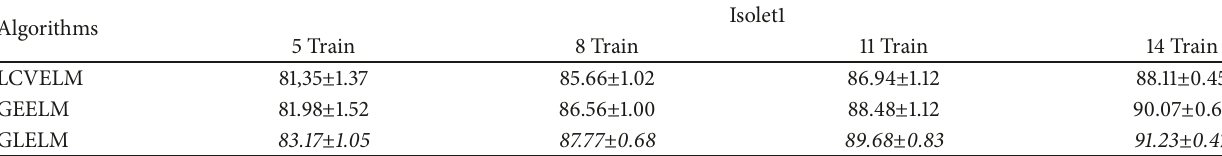
Table 6: Classification accuracy (mean ± std%) of different methods with different numbers of training samples on the Isolet1 database.